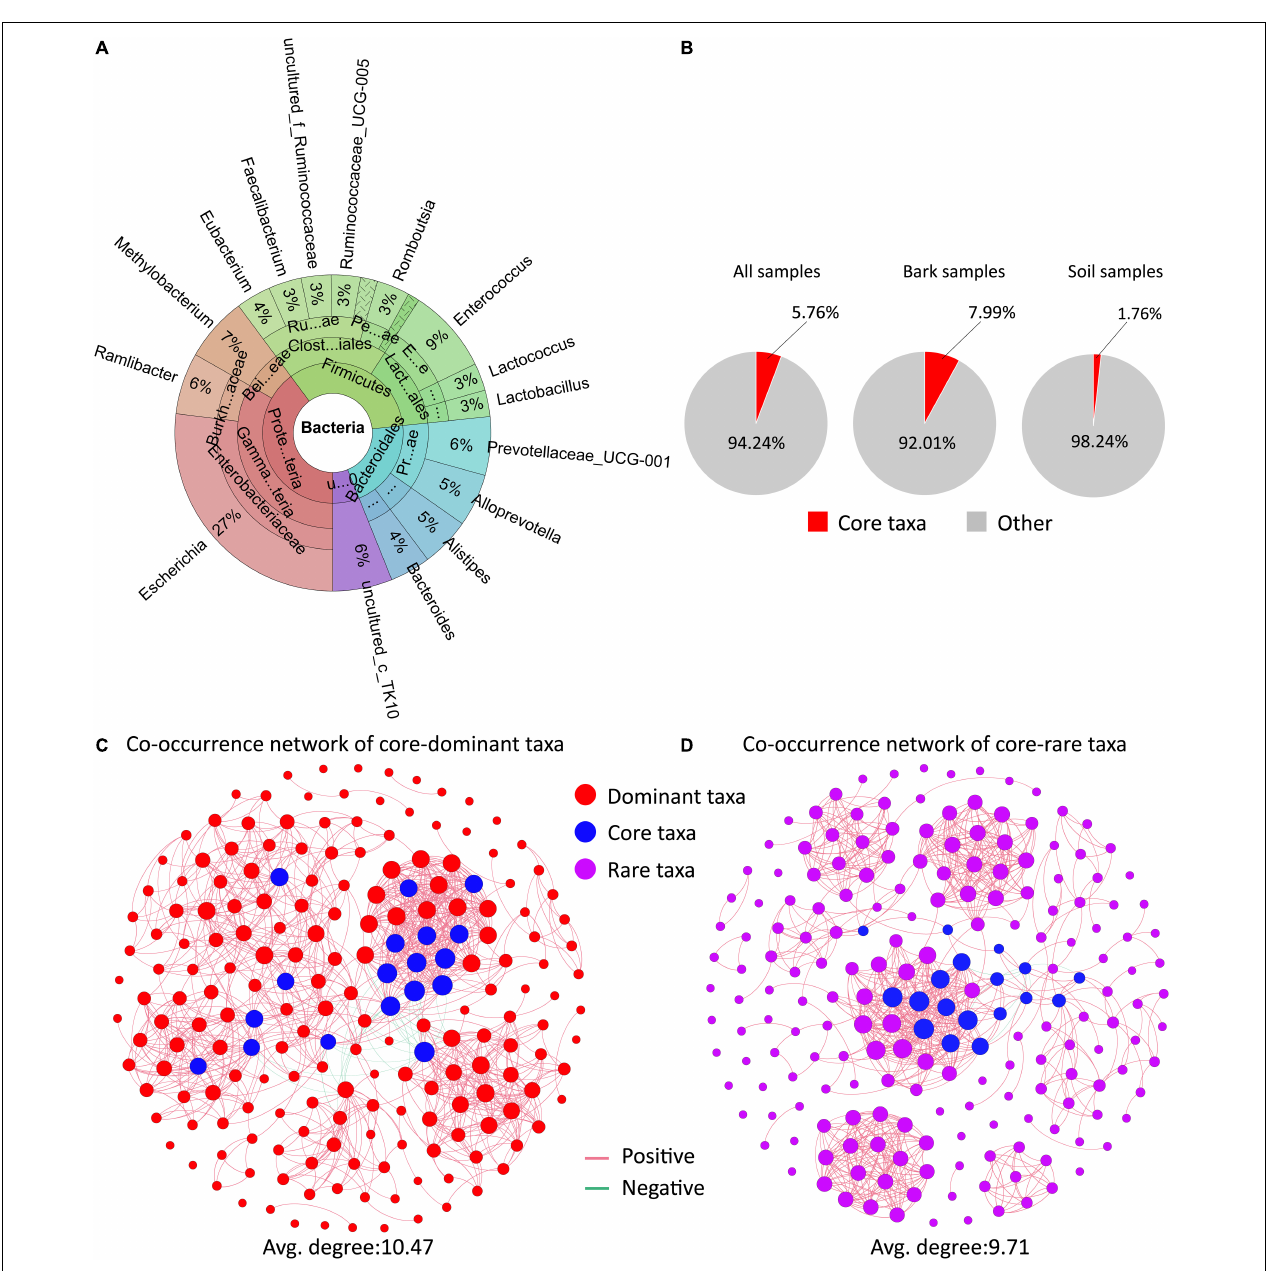
FIGURE 4 | The interactions of the core microbiota with the rare microbiota. (A) Composition and classification information of the core microbiota. (B) Distribution of core microbiota in different samples. (C,D) Bacterial co–occurrence networks along the core taxa–dominant microbiota (C) and core taxa–rare microbiota (D)